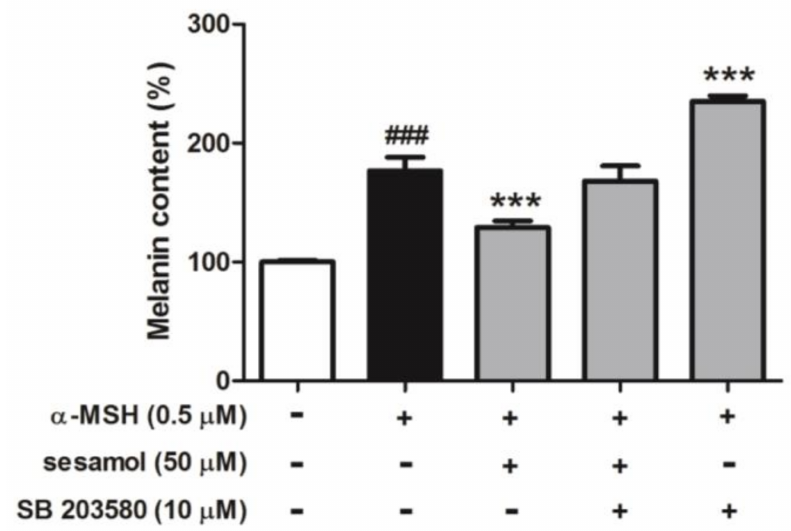
Figure 9. Effects of sesamol and SB 203580 (p38 inhibitor) on melanin content (%) in α -MSH-treated B16F10 cells after 48 h. Each value is presented as the mean ± S.D. ### p < 0.001 (Significant difference versus control); *** p < 0.001 (Significant difference versus α -MSH treated